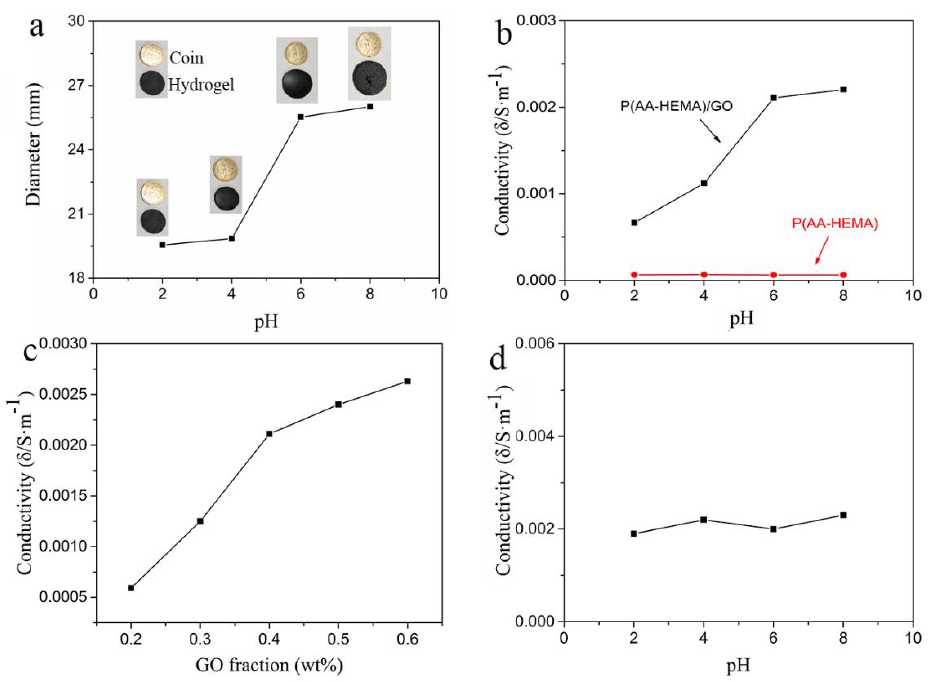
Figure 4. ( a ) The diameter of the hydrogels varies with an increase in pH from 2 to 8 (0.15 M Na 2 HPO 4 and citric acid buffer solution). The yellow circles represent the coin and the black circles represent the hydrogel; ( b ) pH-dependent conducting properties for P(AA-HEMA)/GO and P(AA-HEMA) hydrogels; ( c ) electrical conductivity of the hydrogels with different GO ratios; ( d ) pH-dependent conducting properties for PHEMA/GO hydrogels without AA.